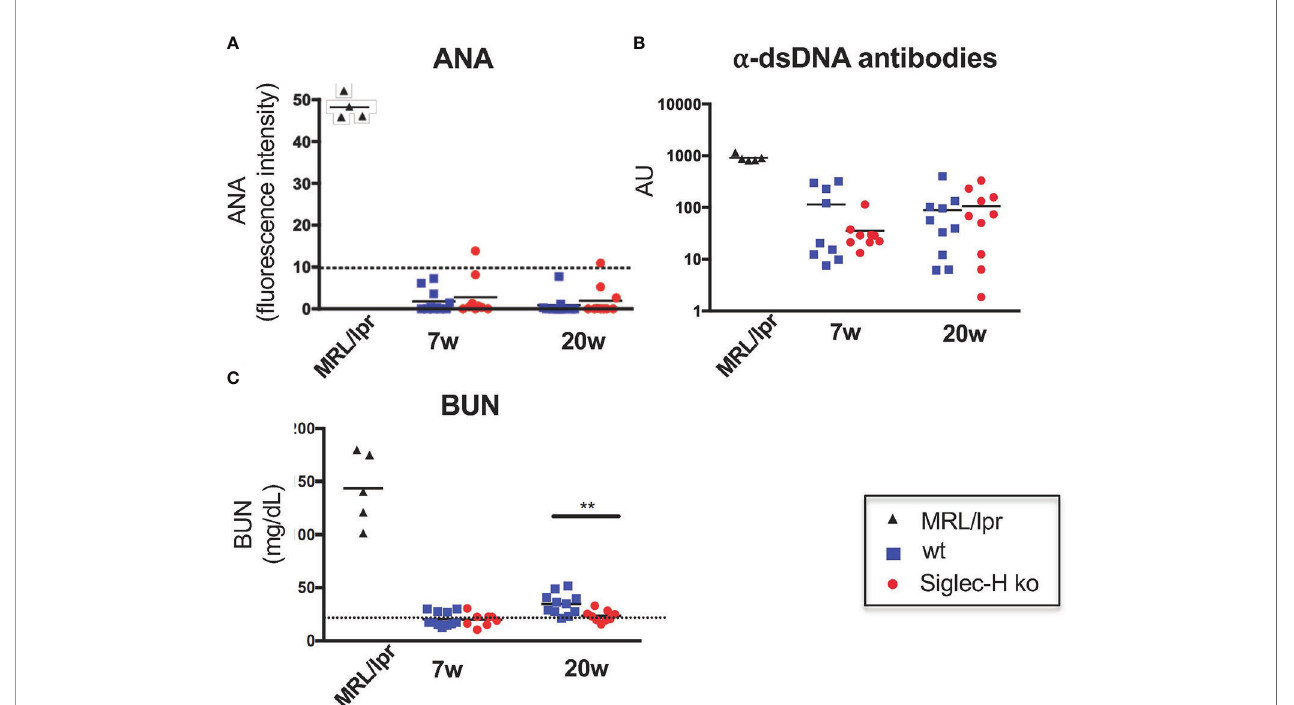
FIGURE 2 | No signs of autoimmunity in Siglec-H ko mice upon in fl uenza infection. Mice were infected with In fl uenza virus H3N2 (10 4 pfu) and sera were analysed for the presence of ANAs, anti-dsDNA antibodies or BUN (blood urea nitrogen). Sera of in fl uenza infected mice were semi-quantitatively analysed on HEp-2 slides (A) . The mean pixel intensity was determined from 10 randomly analysed cells per sample. Each symbol represents the IgG serum ANA level of a single mouse. Representative of one experiment (n = 10 and n = 5 for MRL/ lpr ). (B) Anti-dsDNA antibodies in sera of in fl uenza-infected mice were measured by ELISA. Each symbol represents a single mouse. AU, arbitrary units. (C) Urea nitrogen contents in the blood of in fl uenza-infected mice were determined with an enzymatic BUN kit. Representative of one experiment (n = 10 mice and n = 5 MRL/lpr mice). **p < 0.01; Mann-Whitney test. Sera of MRL/lpr mice served as a positive